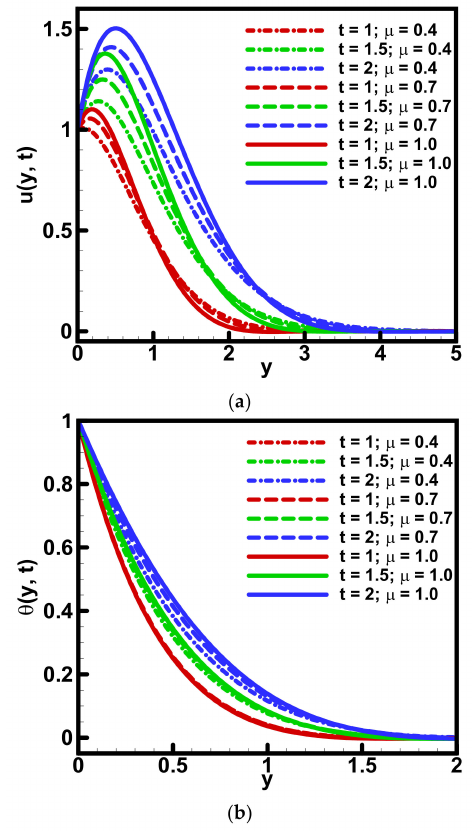
Figure 5. Behavior of ( a ) velocity and ( b ) temperature profiles as varying µ = α = β and t when λ α = Λ 1 = 0.5, φ = 0.01, λ β = Λ 2 = 0.7, Gr = 5, Pr = 2 1